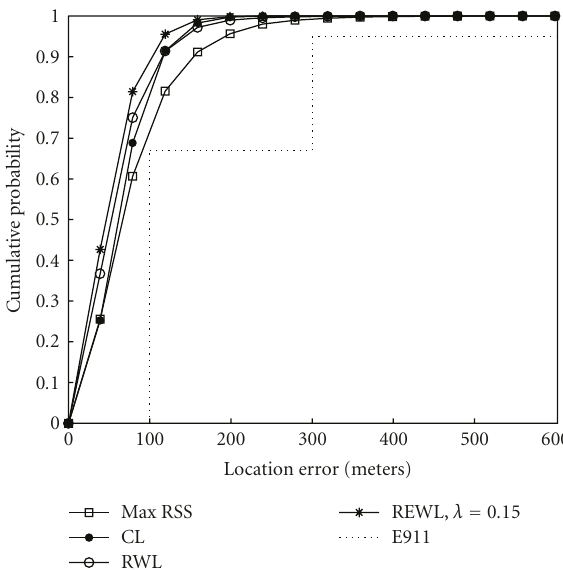
Figure 6: Algorithm location error by number of receivers for 5.8GHz.